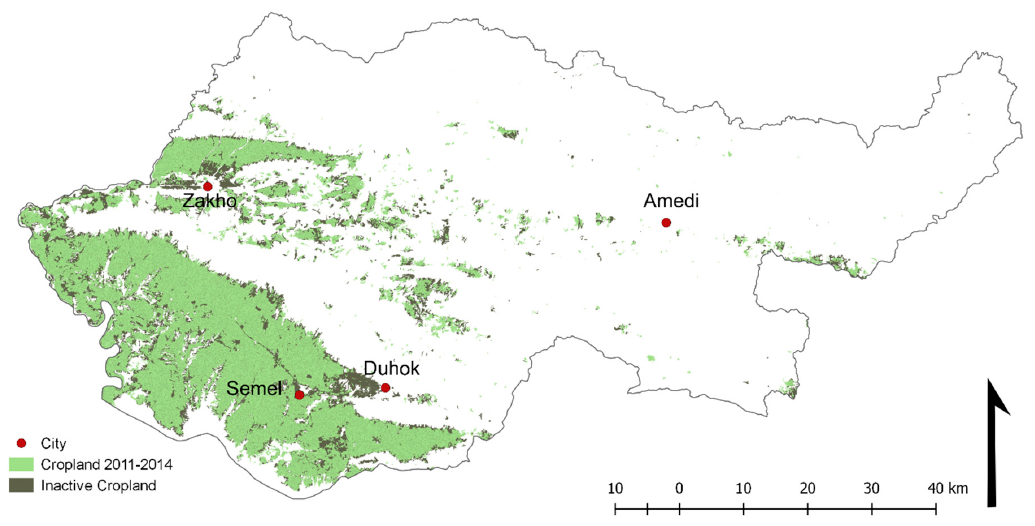
Figure 4. Active and inactive (or converted) cropland in the period 2011–2014.